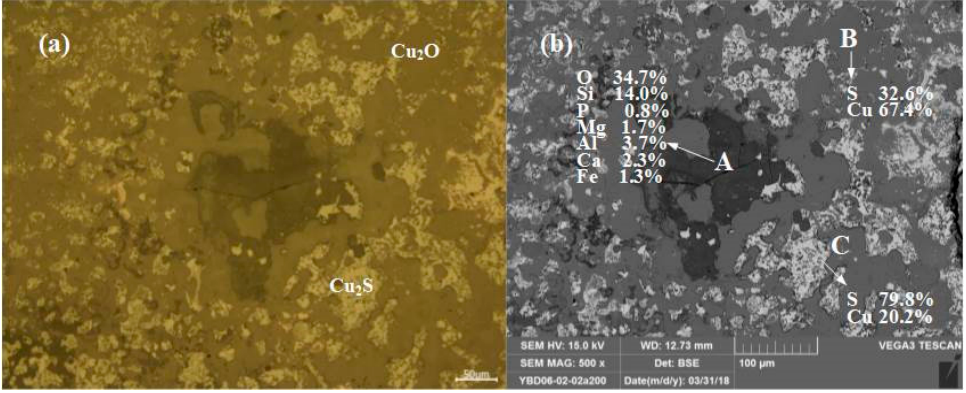
Figure 8. Optical micrograph ( a ) and SEM backscattered electron image ( b ) of YBD06. Sample YBD010: CuFeS 2 (chalcopyrite) was distributed as larger particles within the copper oxide ore, while Cu 2 S (chalcocite) particles were smaller and dispersed throughout the oxide copper ore. As shown in Figure 9.